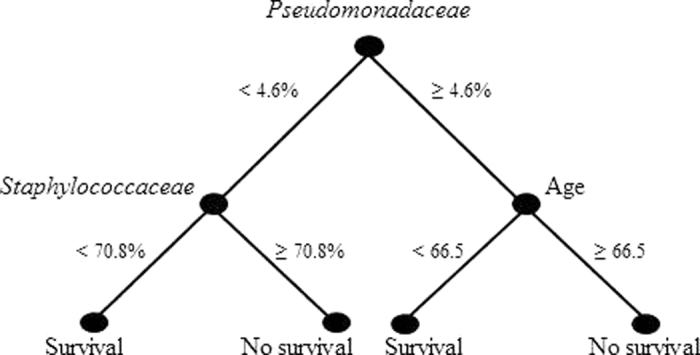
Decision tree predicting patient survival.